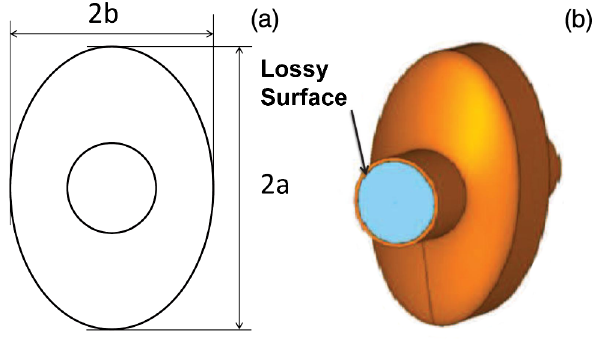
FIG. 2. Elliptical cavity used for investigating the polarized shape effect on wake impedance: (a) transverse profile of the elliptical cavity, the axial ratio is defined as the ratio of long axes a to short axes b ; (b) cavity model with lossy surface to account for the damping